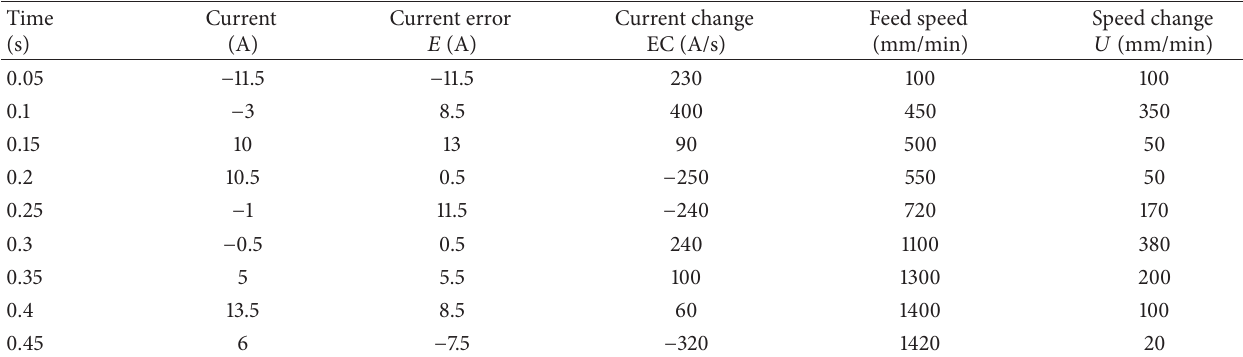
Table 2: The numerical relations between the input and output.